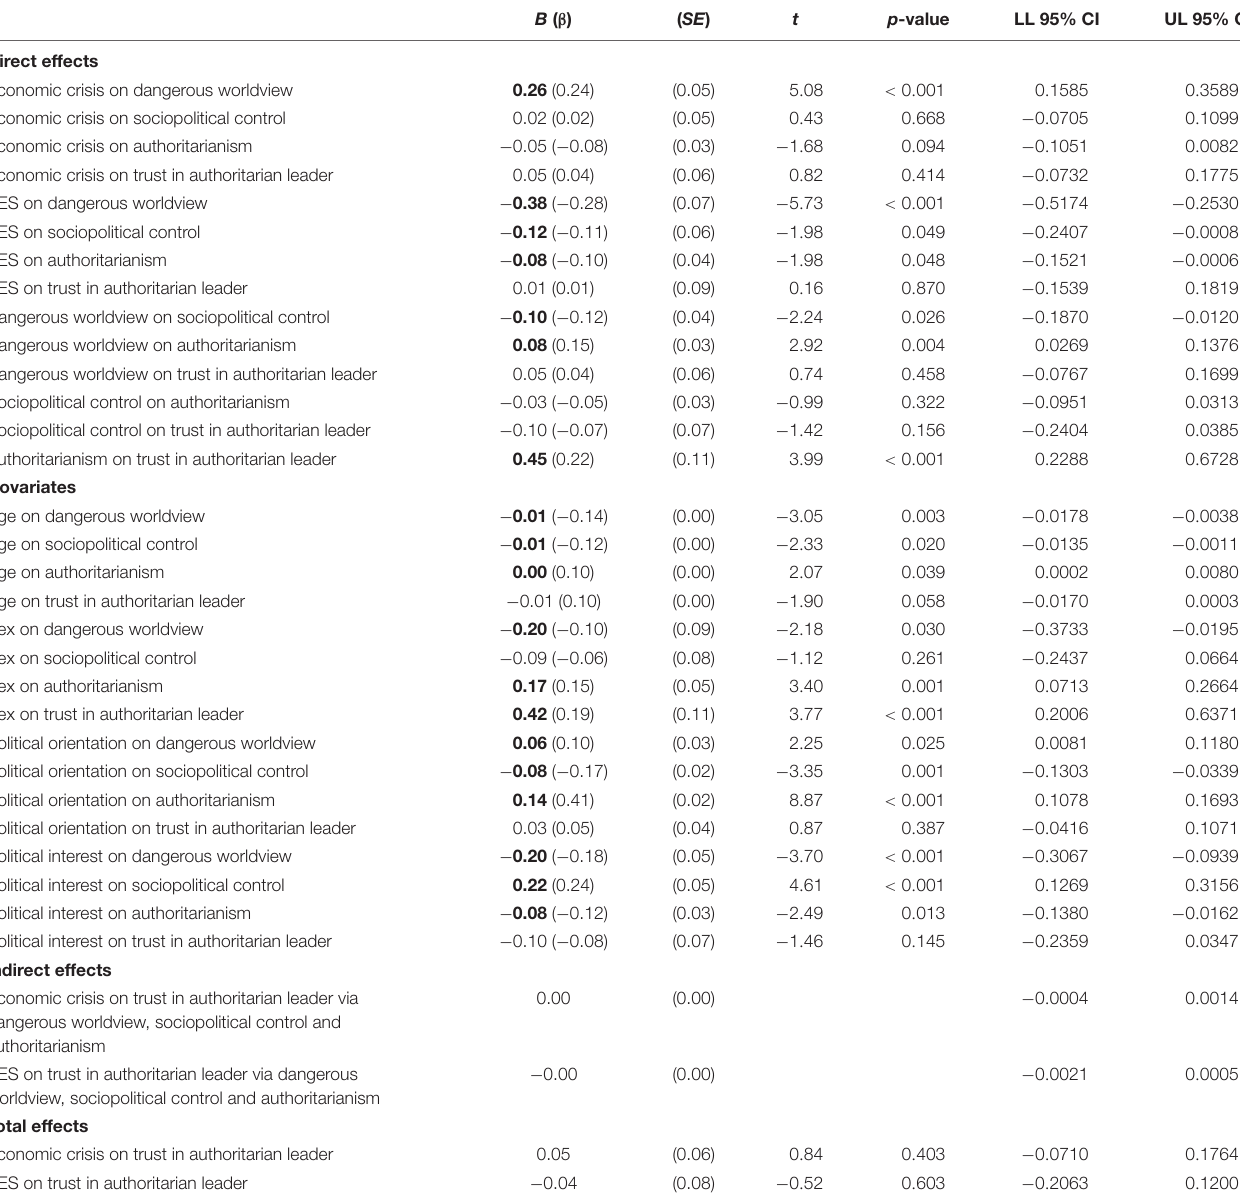
TABLE 4 | Full model for the direct, indirect and total effect of threat by economic crisis and SES on trust in an authoritarian political leader including both predictors in the analysis and controlling by age, sex, political orientation and political interest. B ( β